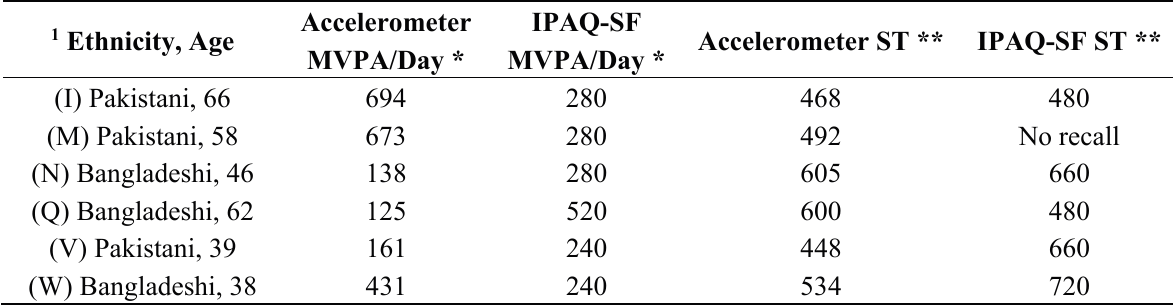
Table 2. Accelerometer and IPAQ-SF PA and ST comparison for the six participants with both forms of